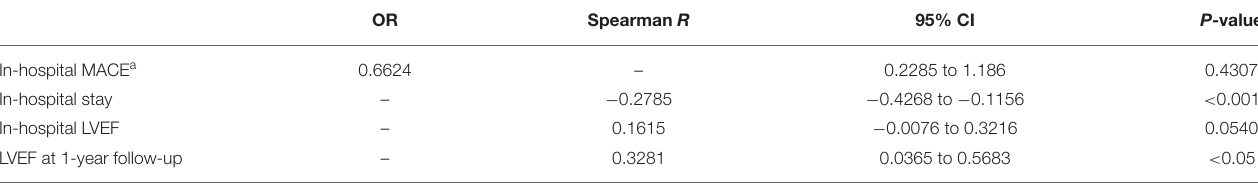
TABLE 6 | Association analysis of HSP70 and study outcomes in MI7d and CCS groups.